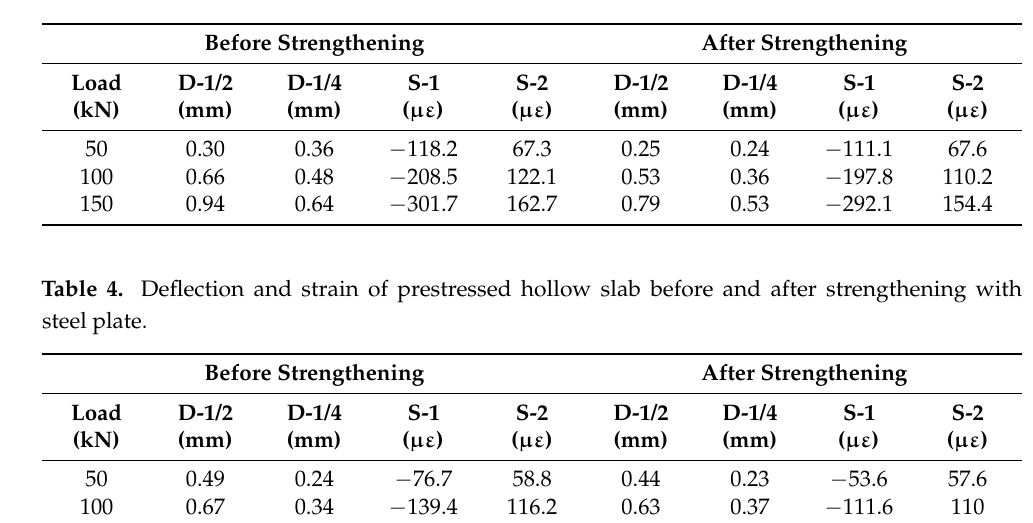
Table 3. Deflection and strain of prestressed hollow slab before and after strengthening with carbon fiber cloth.